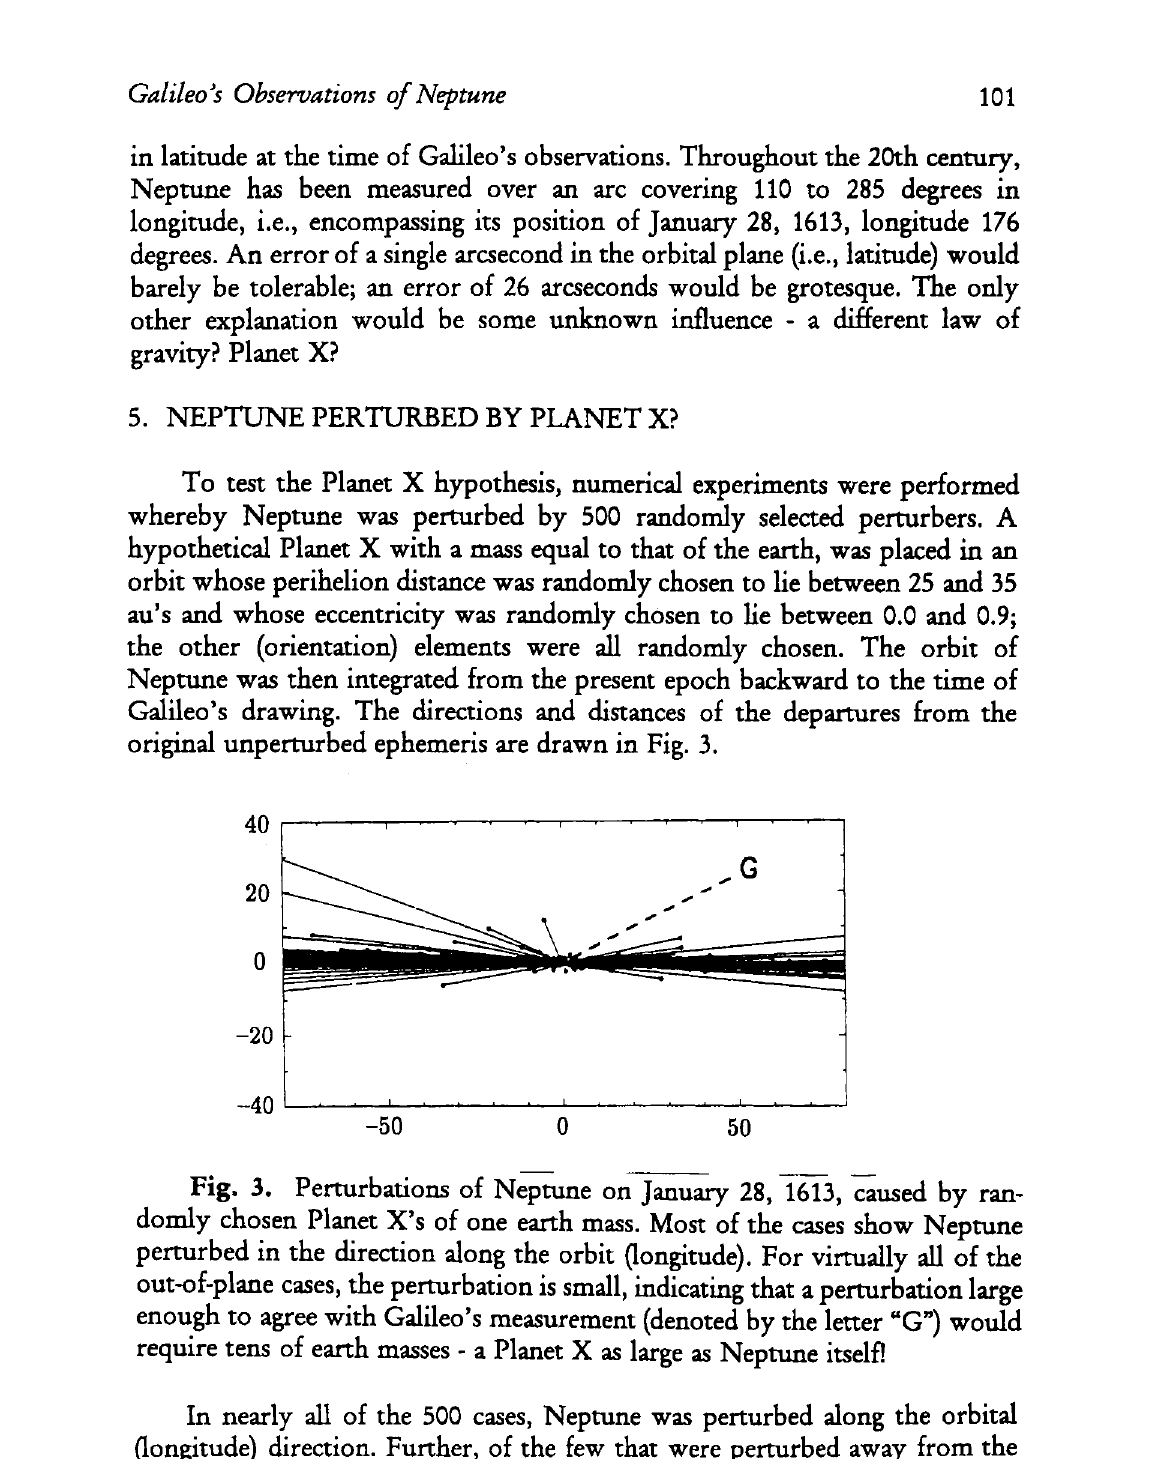
Fig. 3. Perturbations of Neptune on January 28, 1613, caused by ran- domly chosen Planet X's of one earth mass. Most of the cases show Neptune perturbed in the direction along the orbit (longitude). For virtually all of the out-of-plane cases, the perturbation is small, indicating that a perturbation large enough to agree with Galileo's measurement (denoted by the letter a G")